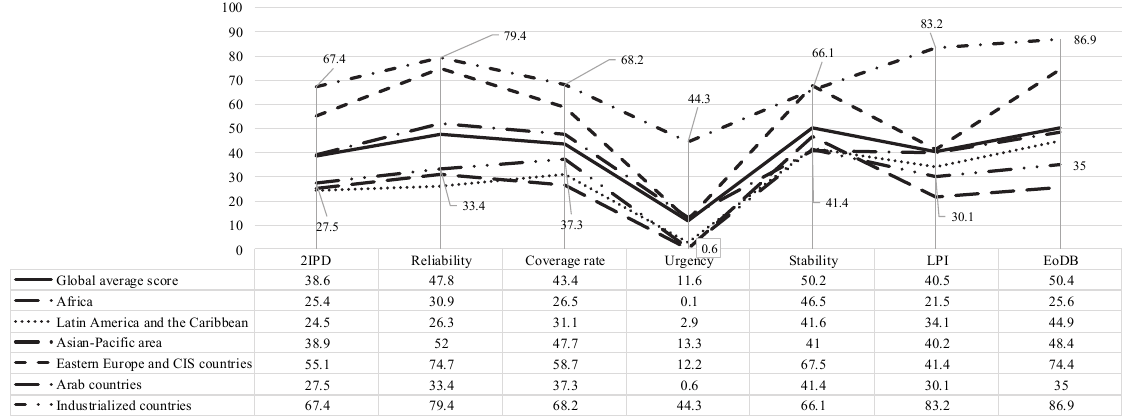
Fig. 1. Review of development indicators of postal services in the context of the world regions Source: Compiled by the author on the basis of data UPU (2016) The postal statistics data makes it possible to note that the industrialized countries reached the highest indicators of development of the mail business. At the same time, there is a general trend - a direct link between the level of development of the economy in the region and the indicators of the development of the postal market. To confirm this trend, we will rank the countries by the global average indicator of the development of the postal market (Table 1). For the group of industrialized countries, the average indicator of 2IPD (Full 2IPD ranking for 2016) is 67.4. The leader of the group is Switzerland, where the shortest period of the average time of delivery of postal items (both internal and external), is 1.6 days (for other countries of this group it is 2-5 days), and the lowest probability of deviations from these terms (up to 2 days, not up to 7 as for other countries in this group). The second and third places in the ranking are respectively: France (94.8) and Japan (94.1). Note that the first hundred of the rating includes all 24 industrialized countries in the world. The average indicator in the Eastern Europe and the CIS countries is 55.1. The leader is Poland (84.9), which is associated with increased attention to the development of services in the field of e-commerce and logistics. The first hundred included 26 of the 28 countries in this group. Among them in the first 20 countries are the following: Poland (7), Slovenia (15), Estonia (18), and Greece (19). These are good indicators. Among the CIS countries, Kazakhstan leads. It takes the 27th place (63.45) and Belarus takes the 32nd place